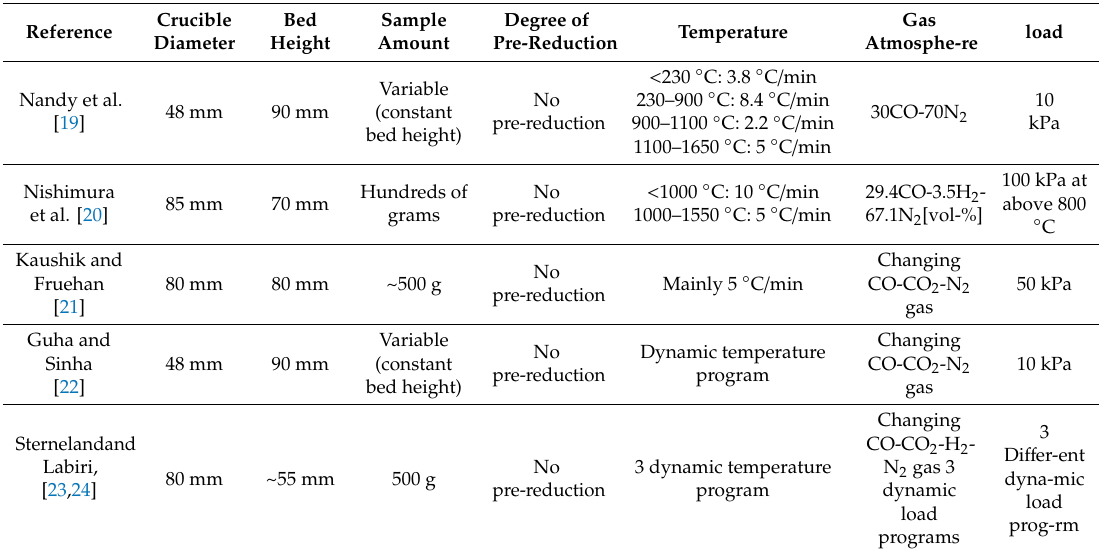
Table 2. Experimental conditions in reduction under load tests reported in the